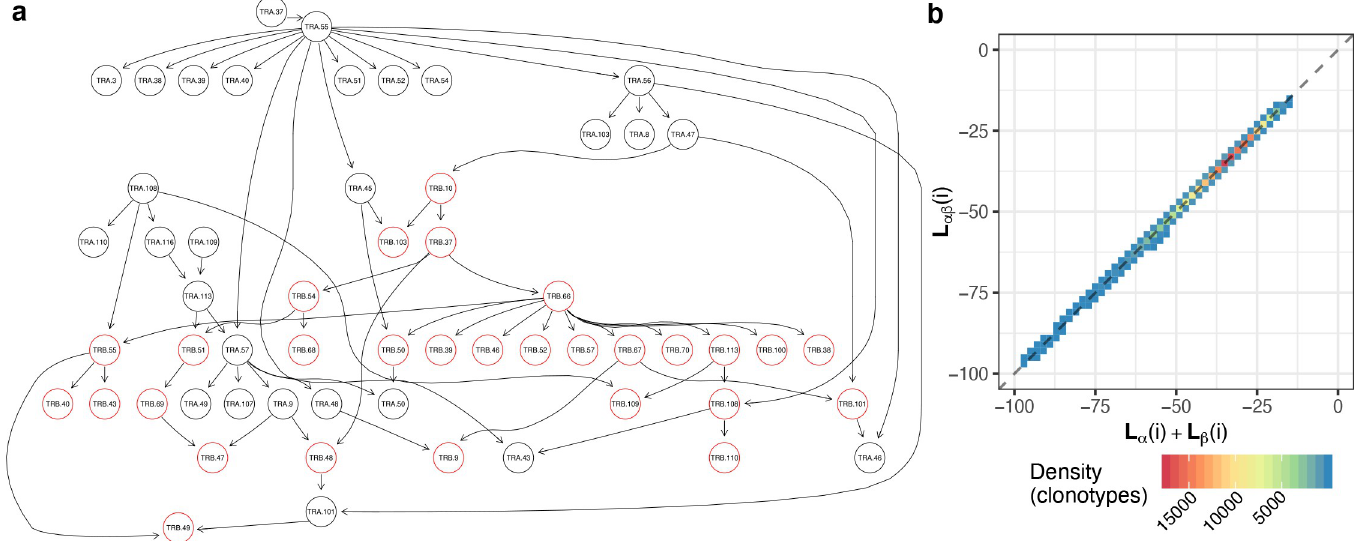
Fig 4. Bayesian network (BN) of TCR αβ complex residues. a. The graph of BN built with separately learned inter-chain contacts (shown in S4 Fig ) whitelisted and residues that are not contacting according to contact frequency thresholding blacklisted. b. A density plot showing correlation between log-likelihood (LL) of BN for paired chains (y axis, computed using the network in a. ) and sum of LLs of individual α and β chains for i th clonotype from PairSEQ dataset. In order to compute individual chain LLs two independent networks were built by removing inter-chain edges and separating α and β residue components of the BN.